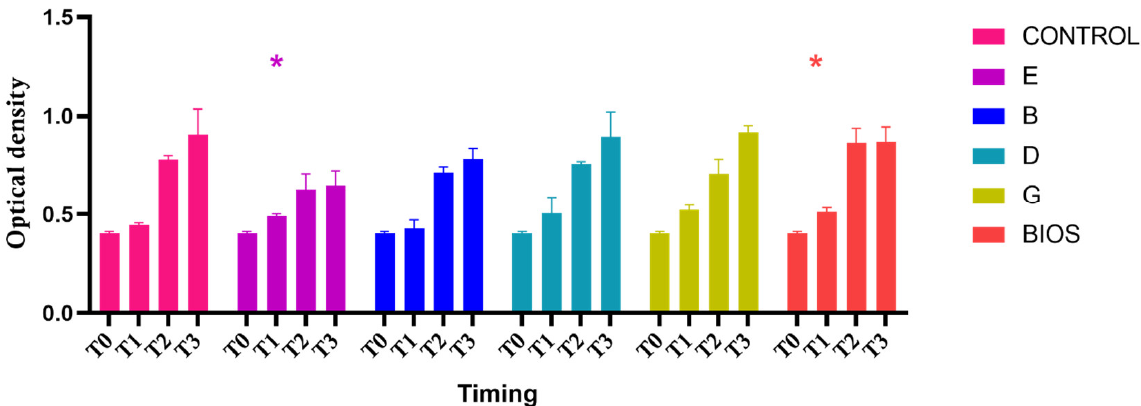
Figure 2. Separated graph bar showing the grouped data of mean and SD of the optical density values ( Y -axis) of the cell not exposed to materials (control), and exposed to the different grafts (B, D, G, E, and BIOS) at the different timings (T0, T1, T2, and T3). * indicates the two-way ANOVA considering the variation in the OD to assess any difference absorbance differences in the considered materials between the group exposed to the experimental materials and the negative control at the different times of seeding (T0) and the T1, T2, and T3 follow-up resulted statistically significant. Table 1. Dunnett’s post hoc multiple comparison results.